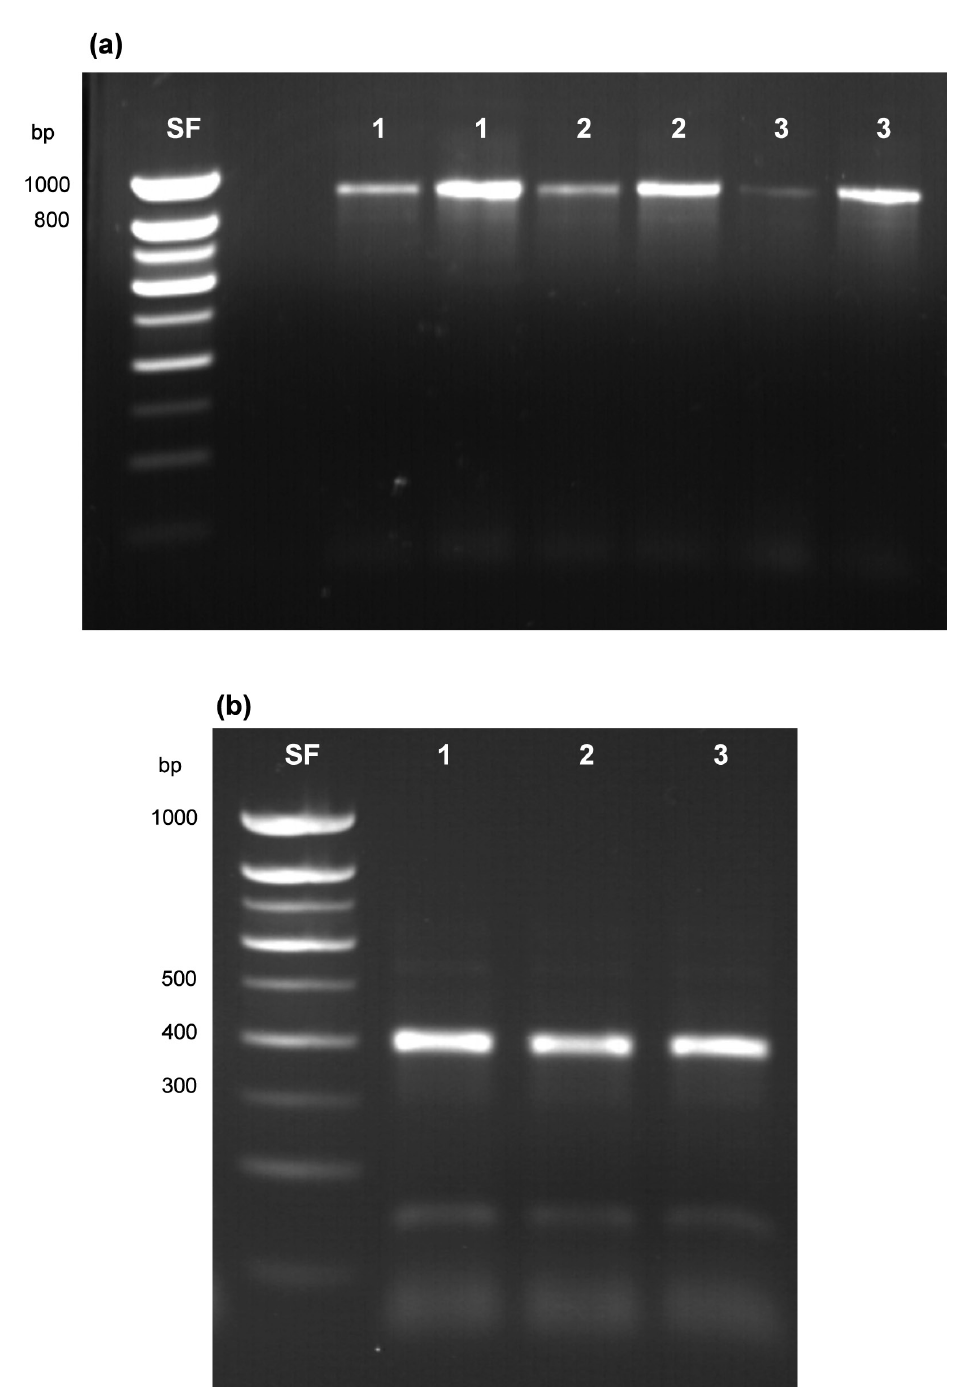
Figure 4. (A) ITS-PCR amplified products on 1.5% agarose gels. 1. Helicotylenchus varicaudatus bigger females (10 and 15 nematodes), 2. H. varicaudatus smaller females (15 and 20 nematodes) and 3. H. varicaudatus males (15 and 20 nematodes). (B) Hinf I-digested PCR-RFLP patterns on 2% agarose gels. 1. Helicotylenchus varicaudatus bigger females (15 nematodes), 2. H. varicaudatus smaller females (20 nematodes) and 3. H. varicaudatus males (20 nematodes). SF=DNA marker, Smart Ladder SF (100 bp ladder, Eurogentec,